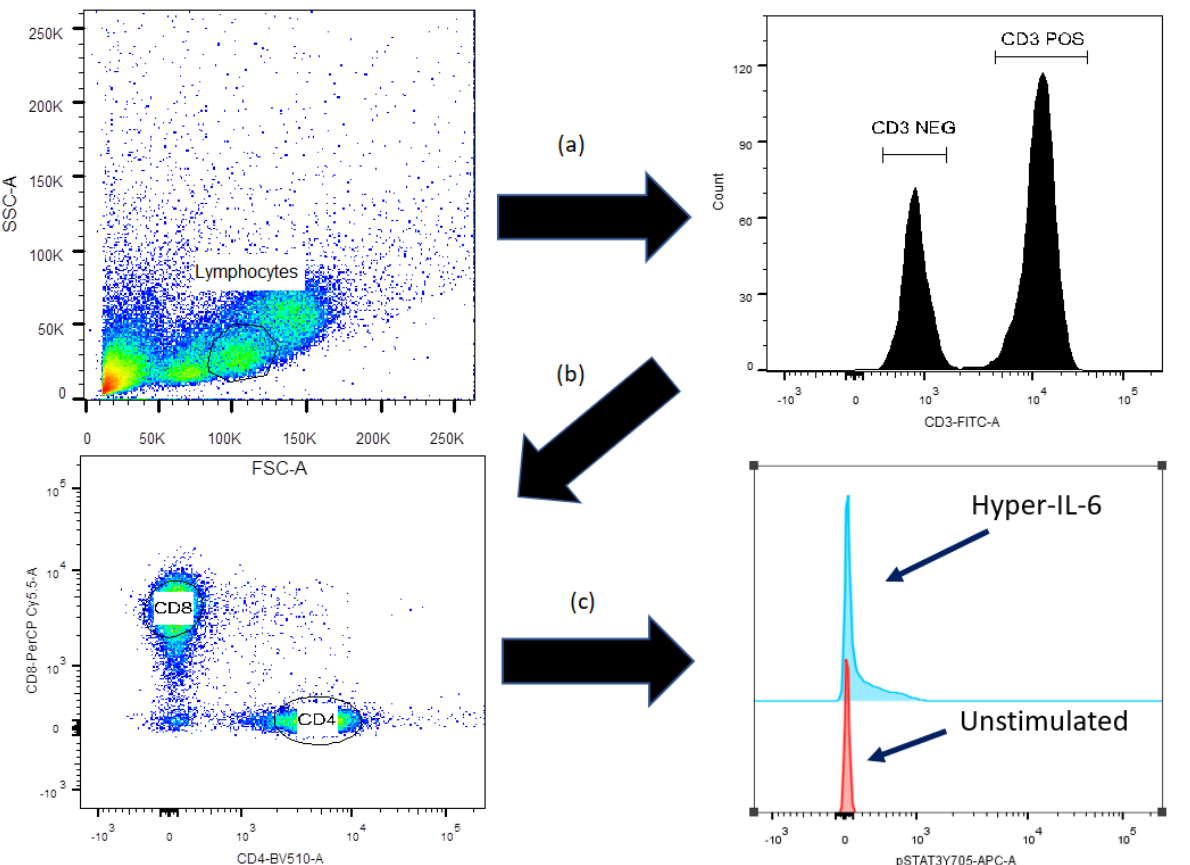
Figure 1. Overview of the gating strategy for comparison of stimulated and unstimulated cells. ( a ) After exclusion of duplicates and dead cells from the lymphocyte gate, CD3 + and CD3 − gates were selected. ( b ) The CD3 + cells were thereafter further divided into CD4 + and CD8 + cells. ( c ) Stimulated samples were finally compared with the unstimulated control cells; this comparison was carried out for the CD3 − , CD3 + CD4 + and CD3 + CD8 + cells. 2.3. Flow-Cytometric Analysis of IL-6R Expression and Intracellular Cytokine Levels Cryopreserved cells were thawed and incubated overnight in X-Vivo 10 medium ® .